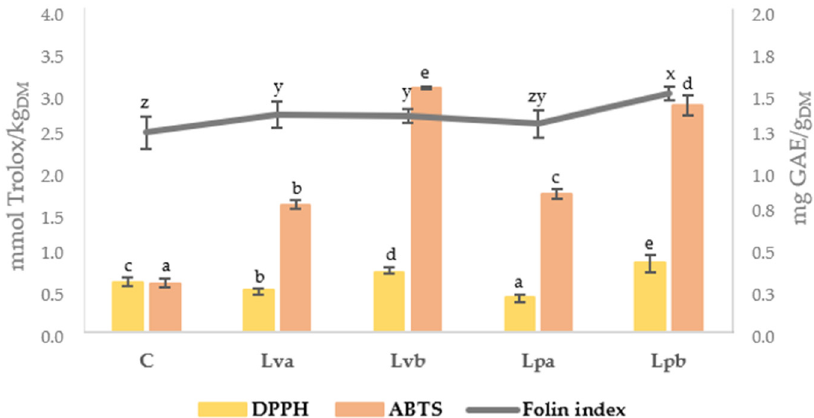
Figure 2. Total phenol content (Folin index) and radical scavenging activity determined by DPPH and ABTS methods of deer burgers after 12 days of chilled storage. C: sodium ascorbate control; Lva: 2.5% “verdejo” lees; Lvb: 5% “verdejo” lees; Lpa: 2.5% “palomino” lees; Lpb: 5% “palomino” lees; DM: dry matter. Di ff erent lowercase letters appearing in the same method for determining antioxidant activity (a–d) and Folin index (z–x) indicate significant di ff erences ( p < 0.05) between